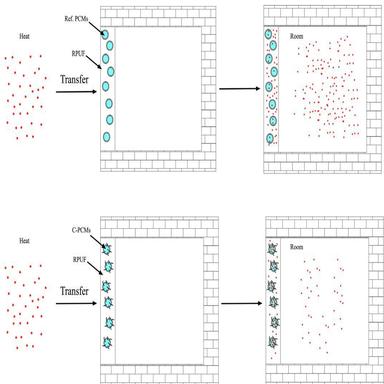
The process of heat transfer among Ref. PCMs and C-PCMs.